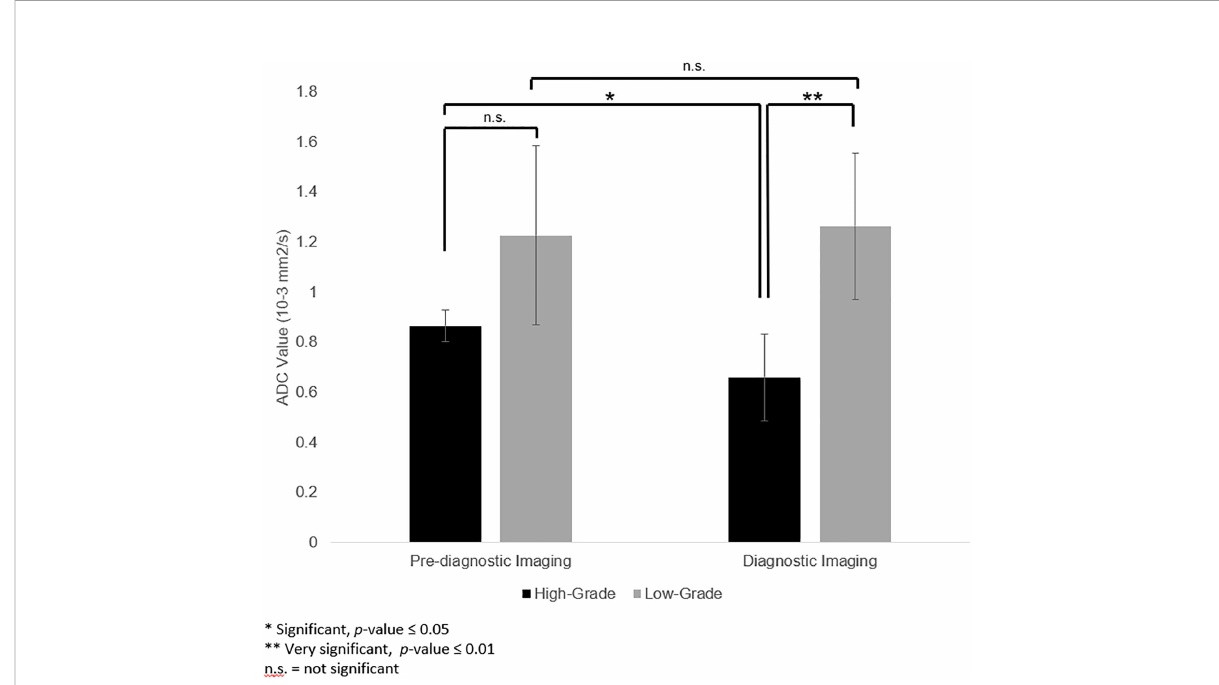
FIGURE 3 Apparent diffusion coef fi cient (ADC) values in the corresponding pre-diagnostic regions of tumor growth compared to ADC values of the tumor at the time of diagnosis. ADC values of high-grade tumors were lower on diagnostic imaging than the corresponding region on pre-diagnostic imaging (p = 0.05). For low-grade tumors, ADC values for low-grade tumors were not signi fi cantly different between pre-diagnostic and diagnostic imaging (p = 0.87). On pre-diagnostic imaging, there was no signi fi cant difference between ADC values of high- and low-grade tumors (p = 0.22). However, at time of diagnosis, the ADC values for the high-grade tumors was lower than the low-grade tumors (p =